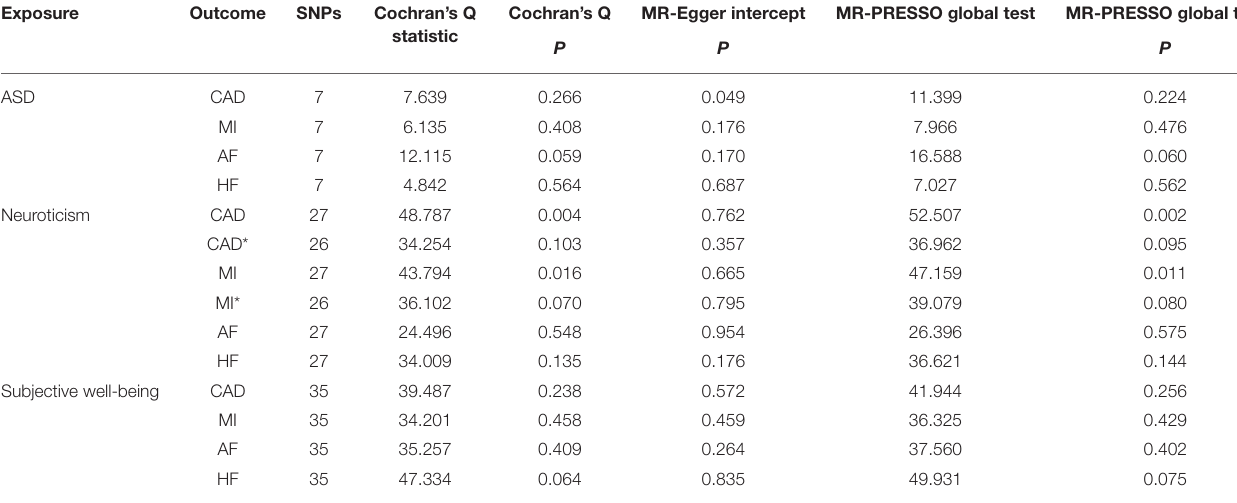
TABLE 2 | Potential pleiotropy evaluation using different methods.